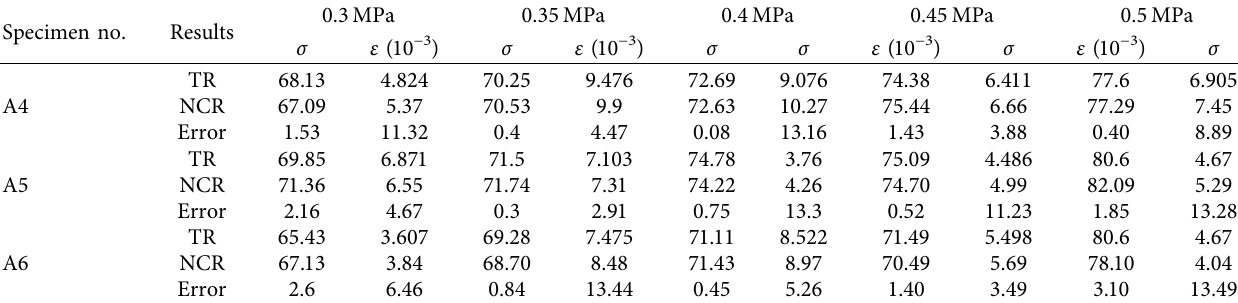
Table 7: Peak stress and peak strain for each specimen.